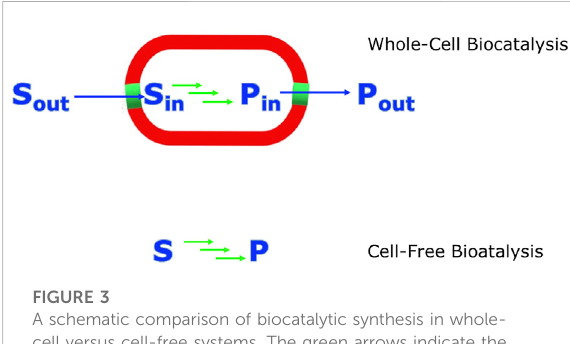
FIGURE 3 A schematic comparison of biocatalytic synthesis in whole- cell versus cell-free systems. The green arrows indicate the biocatalytic reaction steps involved. The blue arrows. indicate the transport of substrates and products across the cell